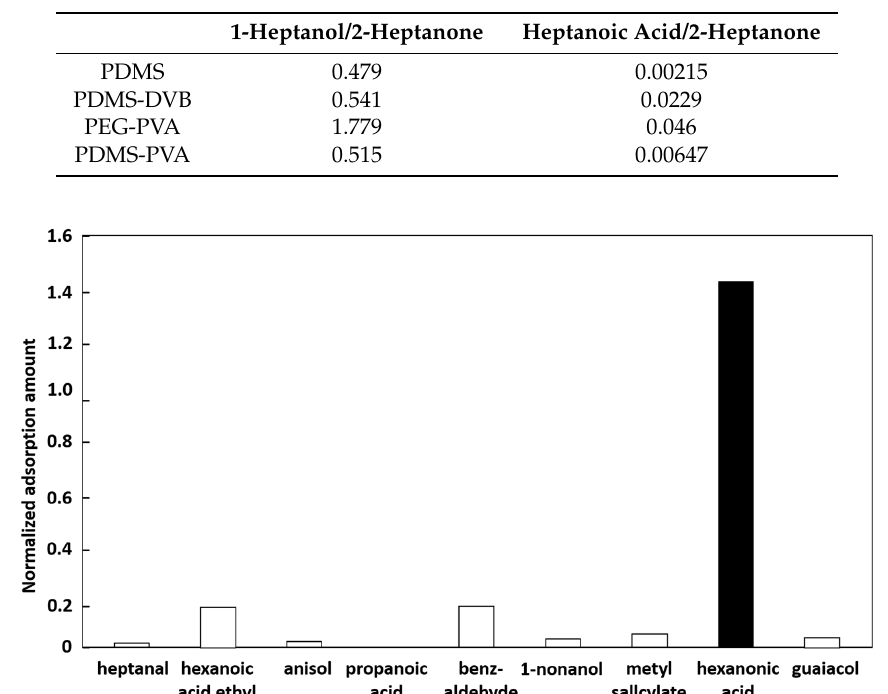
Figure 7. Amounts of gas adsorbed by a molecularly imprinted filtering adsorbent fabricated using hexanoic acid as the template. The amounts are normalized relative to the amounts of gas adsorbed by a polyvinyl chloride–dioctyl phthalate (PVC-DOP) adsorbent without a molecularly imprinted filter.